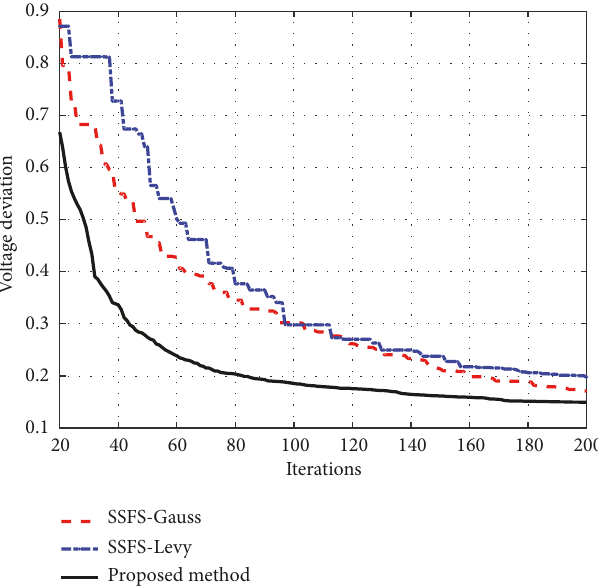
Figure 14: The best run obtained by three methods for voltage deviation optimization of IEEE 118-bus system.